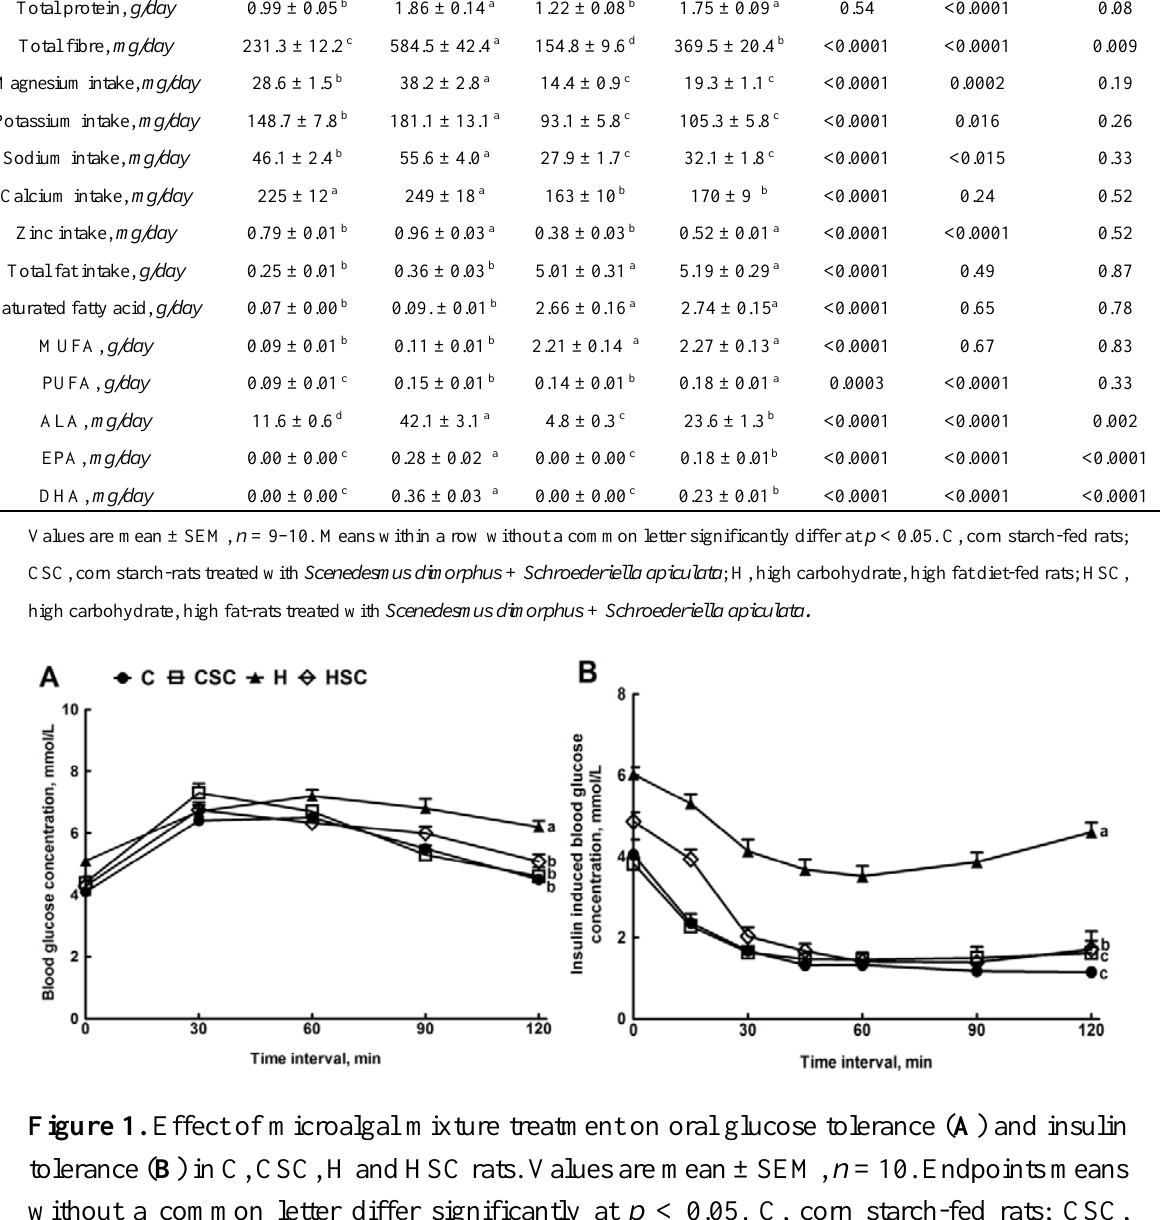
Table 1. Protein, fibre, mineral ion and fat intake in C, H, CSC and HSC rats. Variable